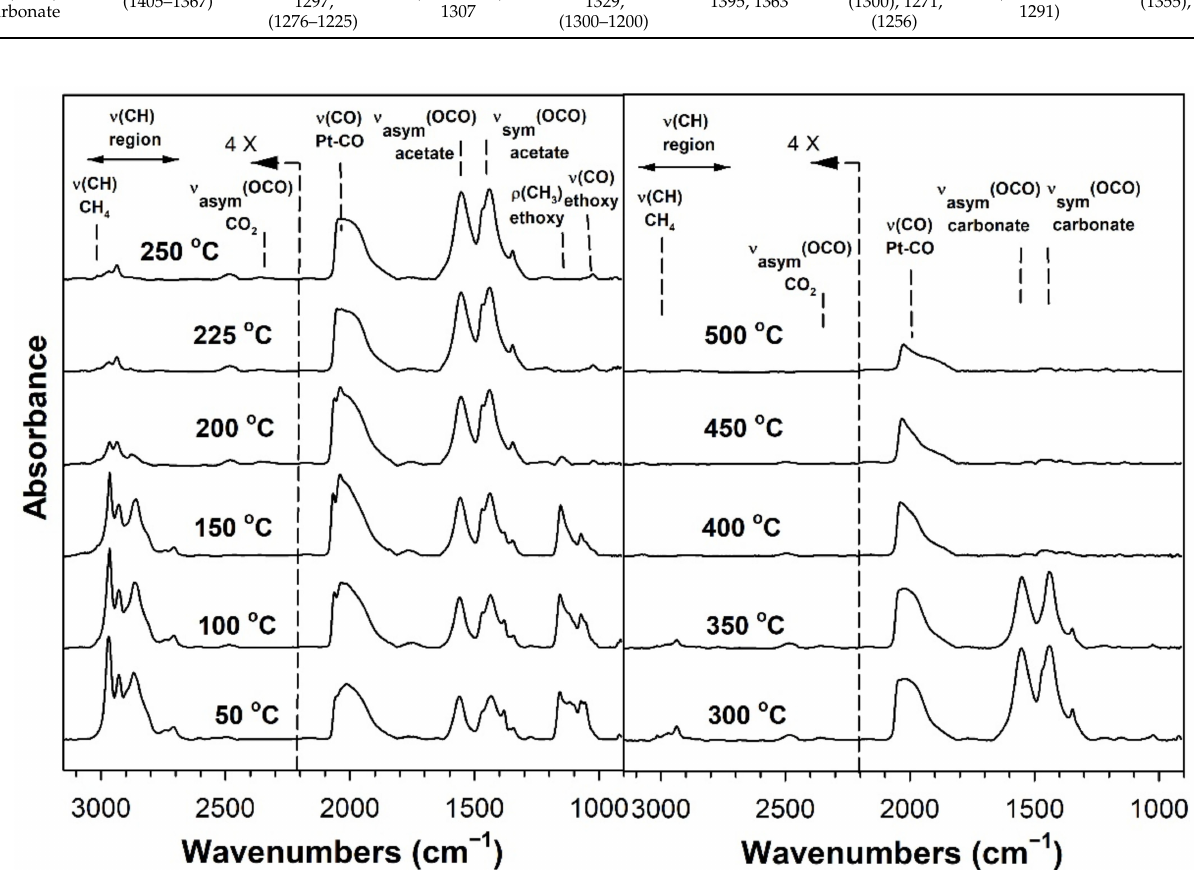
Figure 4. DRIFTS spectra of transient ESR over 2% Pt/m-ZrO 2